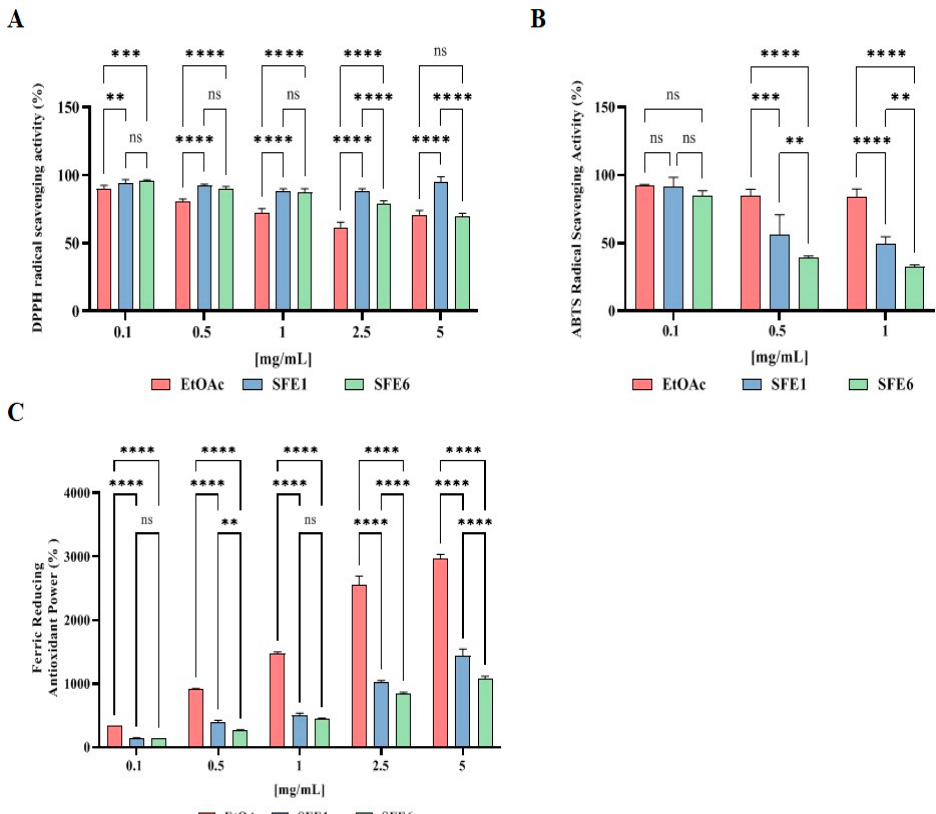
Figure 4. ( A ) In vitro radical scavenging activity by the DPPH assay. ( B ) In vitro radical scavenging activity by the ABTS assay. ( C ) In vitro radical scavenging activity by the FRAP assay. Data represent the mean ± s.d. of three determinations performed in triplicate. All the data sets have been analyzed by two ‐ way ANOVA followed by Šidák correction. ns: not significant, (**) p < 0.01, (***) p < 0.001 and (****) p < 0.0001.